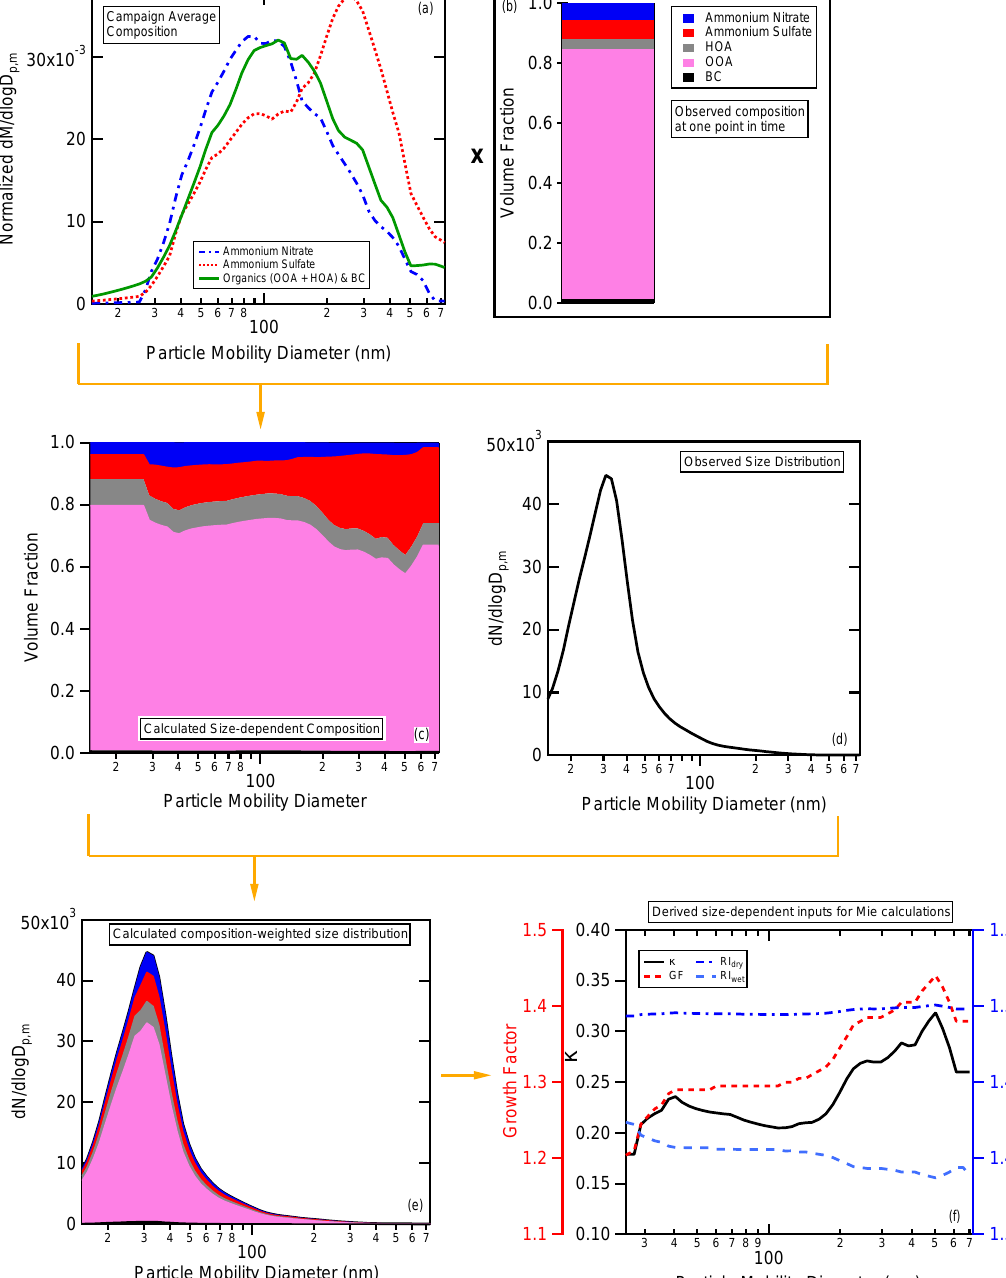
Figure 2. Schematic of the process for determining size-dependent hygroscopic growth factors and real refractive indices. The top panels ( a and b ) illustrate how the observed campaign-average size-dependent normalized particle composition and the time-dependent particle com- position are combined to yield the time- and size-dependent particle composition ( c ). The resulting size-dependent particle composition is combined with the time-dependent size distribution ( d ) to yield a time-dependent size distribution with size-dependent composition ( e ). The resulting size distribution is then used to determine size-dependent growth factors, κ values and real refractive indices ( f